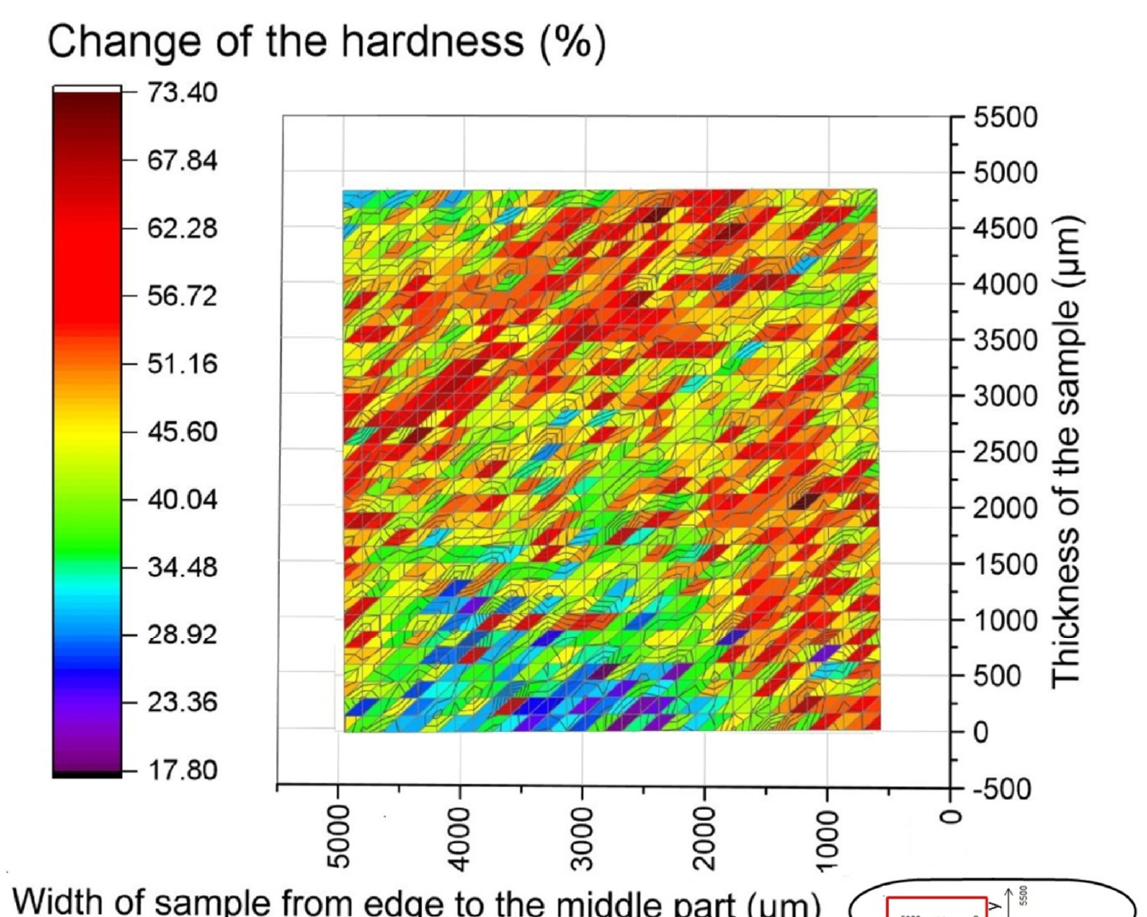
Figure 4. Change of the nano-hardness of the sample ε 6 (in %).